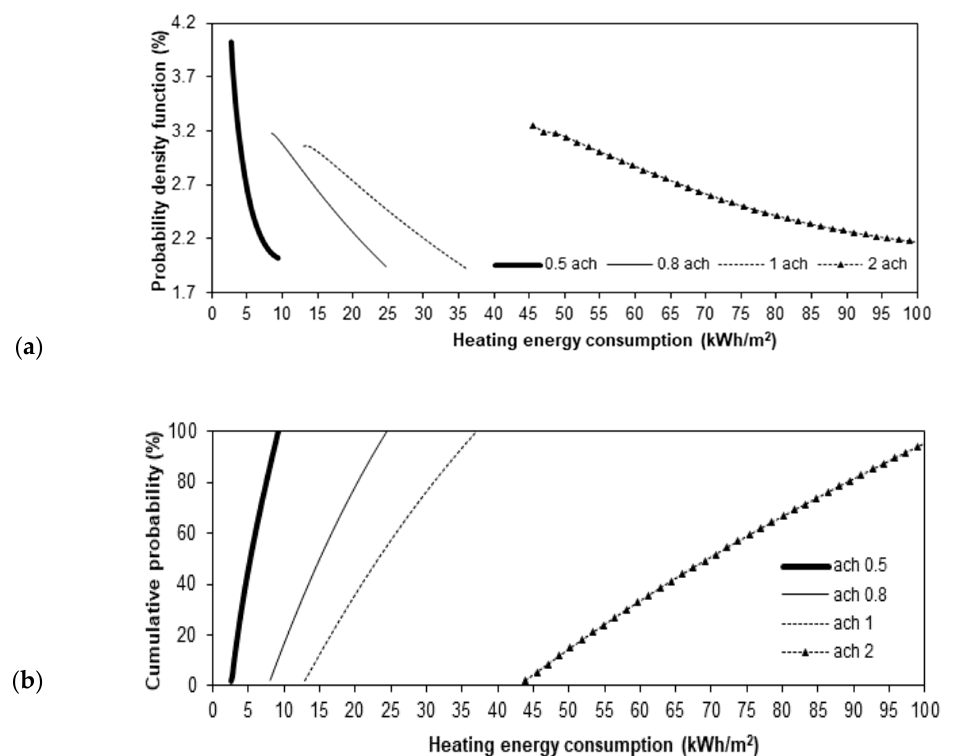
Figure 5. Probability density functions ( a ) and cumulative probability ( b ) of the heating energy consumption for an increment of +1 °C in the outdoor temperature.